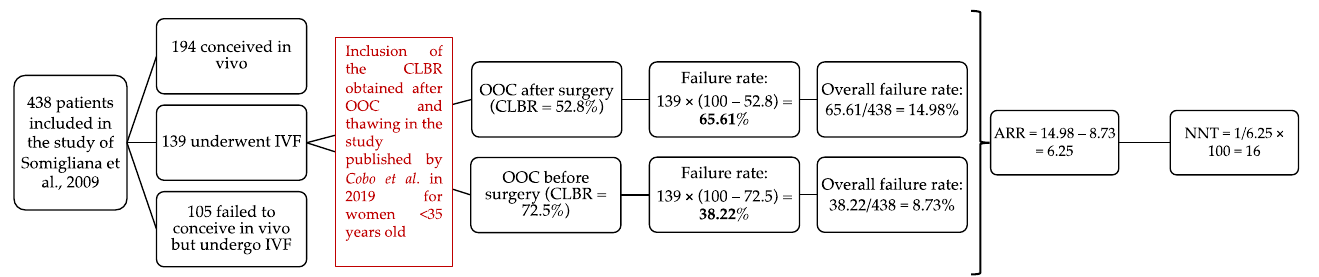
Figure 2. Calculation of number of women in whom cryopreservation before surgical treatment of endometriosis must be performed to guarantee one live birth. IVF: in vitro fertilization, ARR: absolute risk reduction, NNT: number needed to treat, CLBR: cumulative live birth rate. Success rate = patients undergoing IVF in the publication of Somigliana et al. [22] × CLBR [11]. Failure rate = patients undergoing IVF in the publication of Somigliana et al. [22] × (100 – CLBR [11]). Overall failure rate = failure rate/total of patients included in the study of Somigliana [22]. ARR for cryopreservation before surgery was calculated by establishing the difference in absolute risk between the group of patients who underwent surgery before cryopreservation and the second group of patients who realized fertility preservation before surgery. NNT was calculated by 1/ARR × 100. It corresponded to the number of women in whom cryopreservation before surgical treatment of endometriosis must be performed to guarantee one live birth.